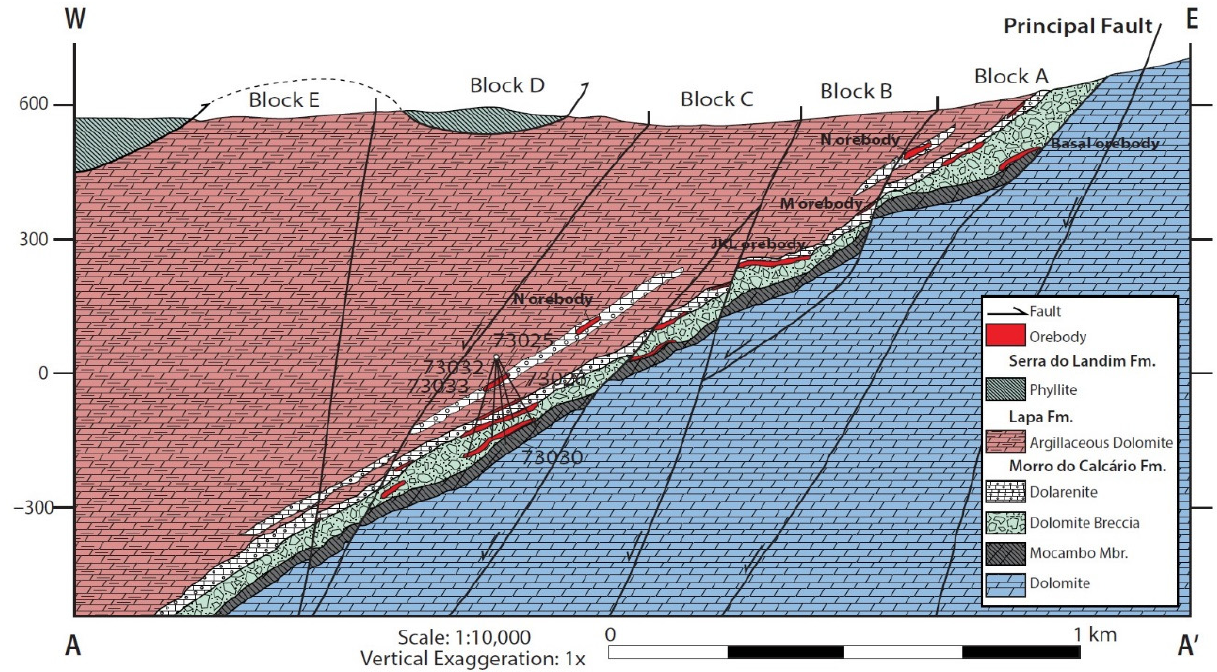
Figure 4. Cross-section of section 580 of the Morro Agudo deposit displaying the varying lithologies, stratigraphic positioning of the orebodies, location of drill holes, and orientation of structural features (modified from [4,15]).